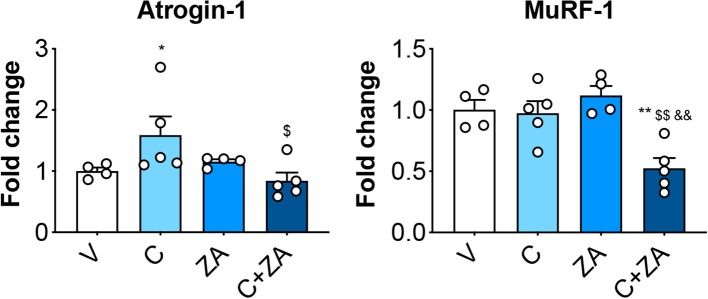
Muscle protein hypercatabolism is counteracted by ZA administration in C-treated mice. mRNA expression for the ubiquitin ligases Atrogin-1 and MuRF-1 in the quadriceps muscle of mice treated with cisplatin and/or ZA (n = 4–5). Data are shown as means ± SEM. Significance of the differences: *p < 0.05, **p < 0.01 vs. V; $p < 0.05, $$p < 0.01 vs. C; &&p < 0.01 vs. ZA.